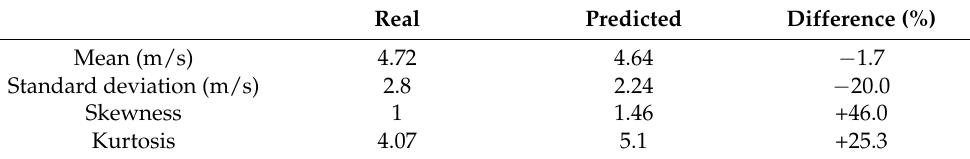
Table 4. Statistical variables for the distributions at h = 210 m for both the bagging and random forest